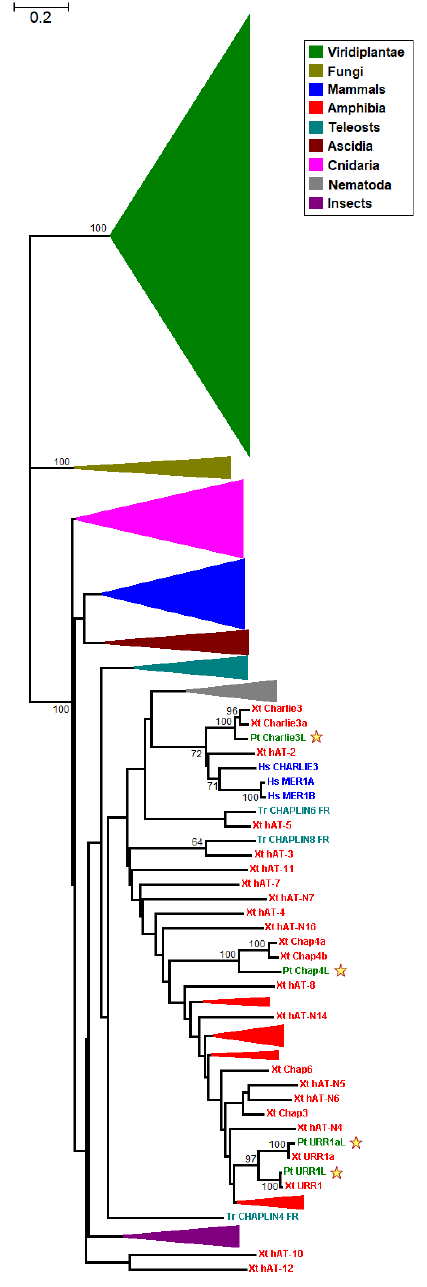
Figure 1. Unrooted neighbor-joining (NJ)-based tree of hAT transposon sequences. The major clades are collapsed for clarity. Taxa are represented by different coloring (inset). The four putative plant sequences are indicated by stars. The branch lengths depict evolutionary distance. Bootstrap values greater than 50% are shown at the nodes. The scale bar at the upper right indicates the length of nucleotide substitutions per site.